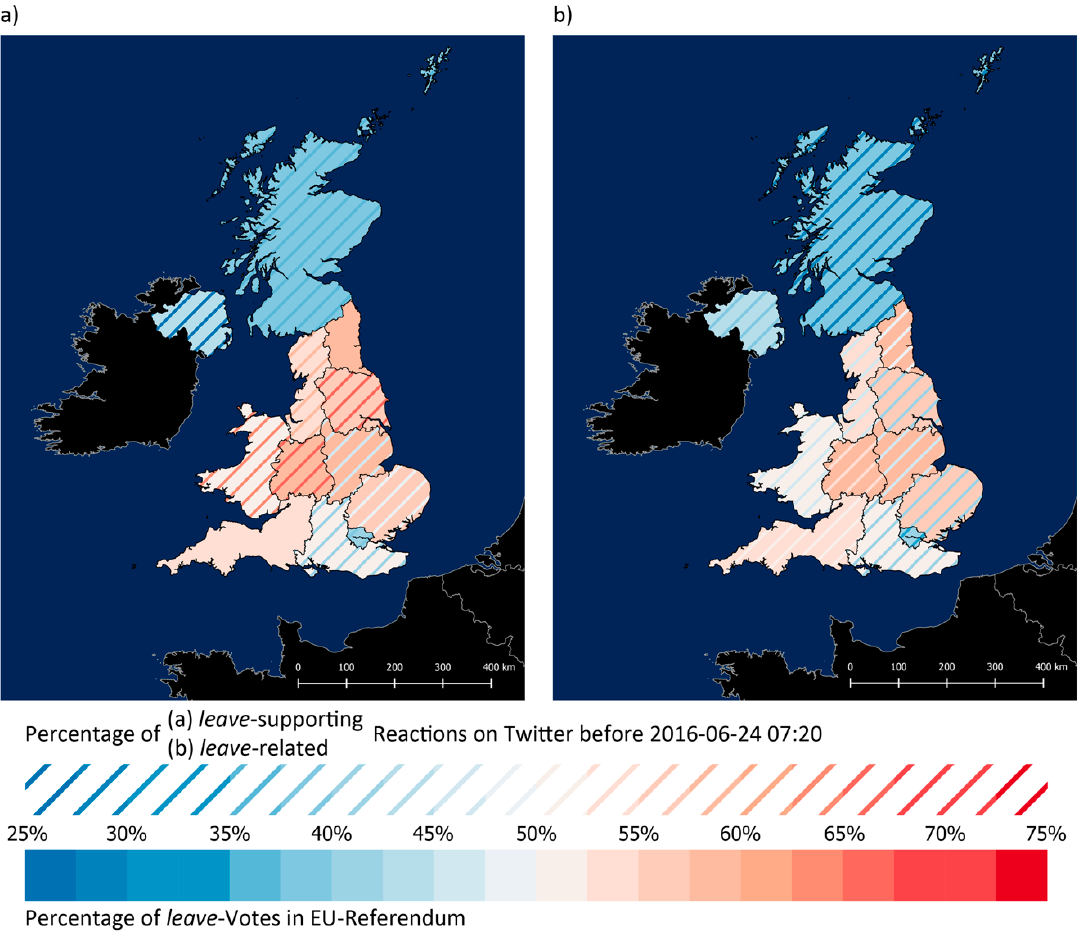
Figure 7. Results of the EU referendum and prior reactions on Twitter ( a ) including sentiment and ( b ) excluding sentiment.